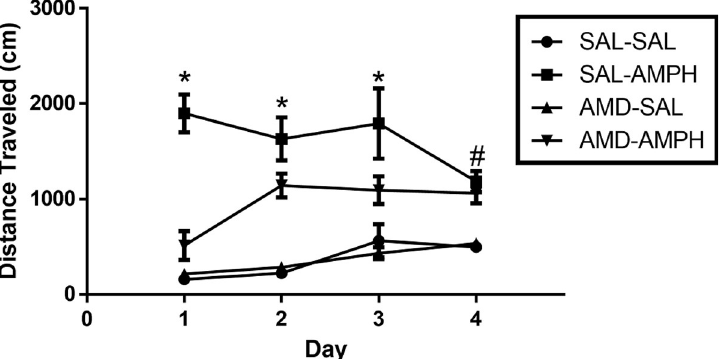
Fig 3. The effect of pretreatment and treatment conditions on average cumulative distance traveled (cm) across the four days of testing and on challenge.